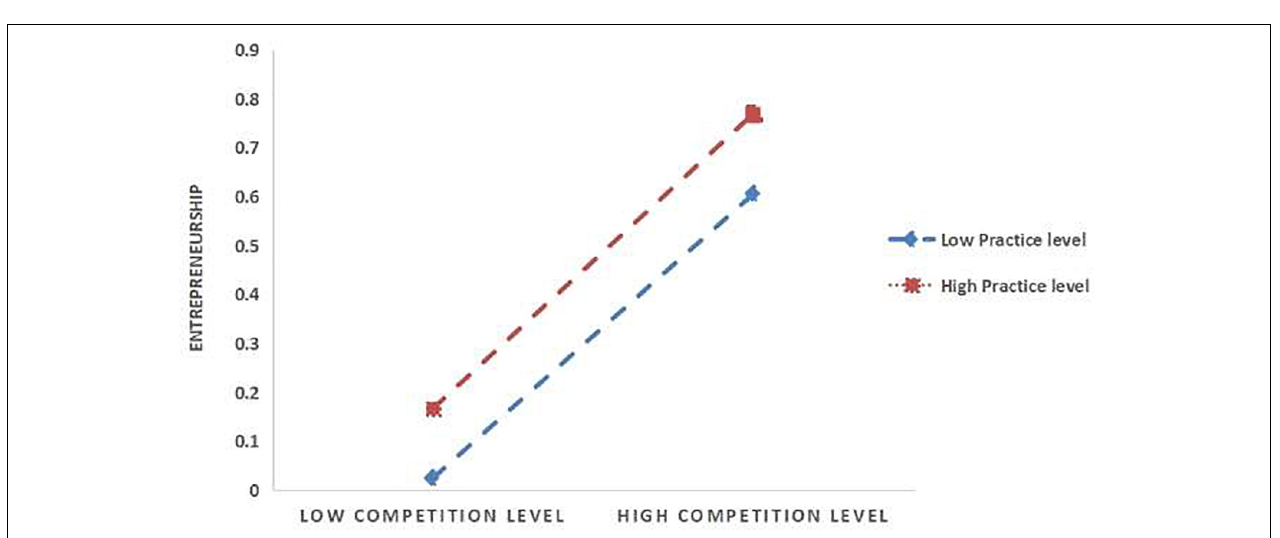
FIGURE 2 | The moderating role of entrepreneurial practice in the relationship between entrepreneurship competition and entrepreneurial competence.